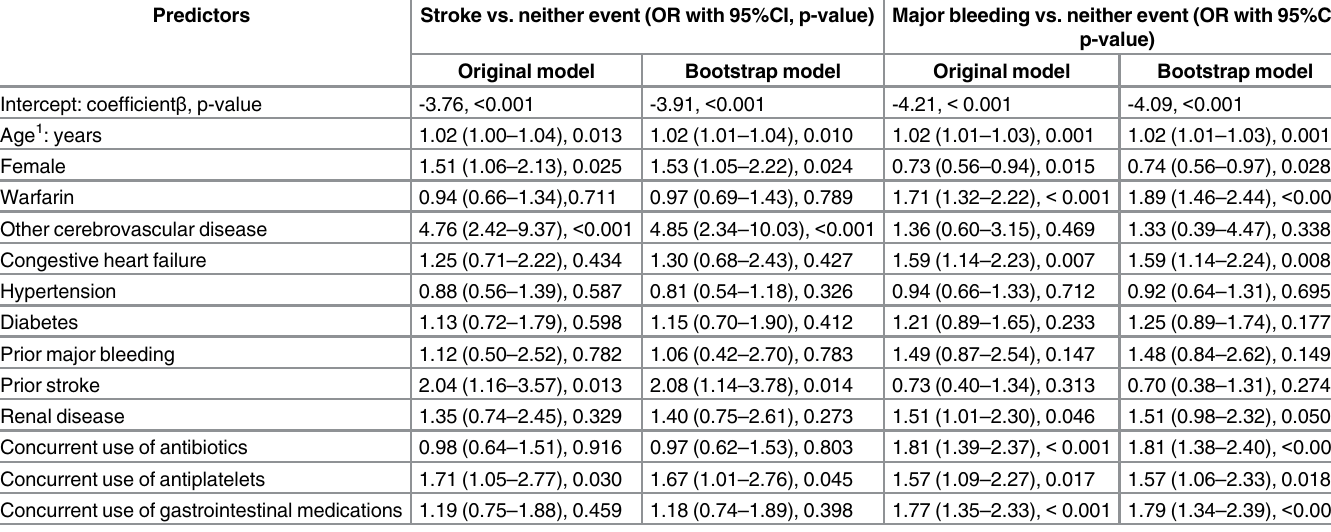
Table 4. Results of the original PLR model and bootstrap analyses for stroke and major bleeding in KPCO-I cohort.